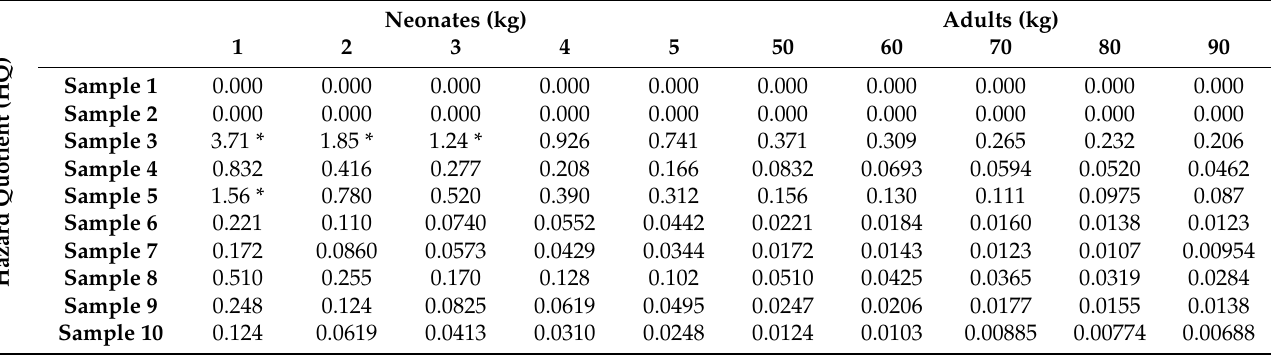
Table 1. Risk assessment of di-(2-ethylhexyl) phthalate (DEHP) exposure in the analyzed IV- bag solutions. Numbers represent the hazard quotient (HQ) measured using the